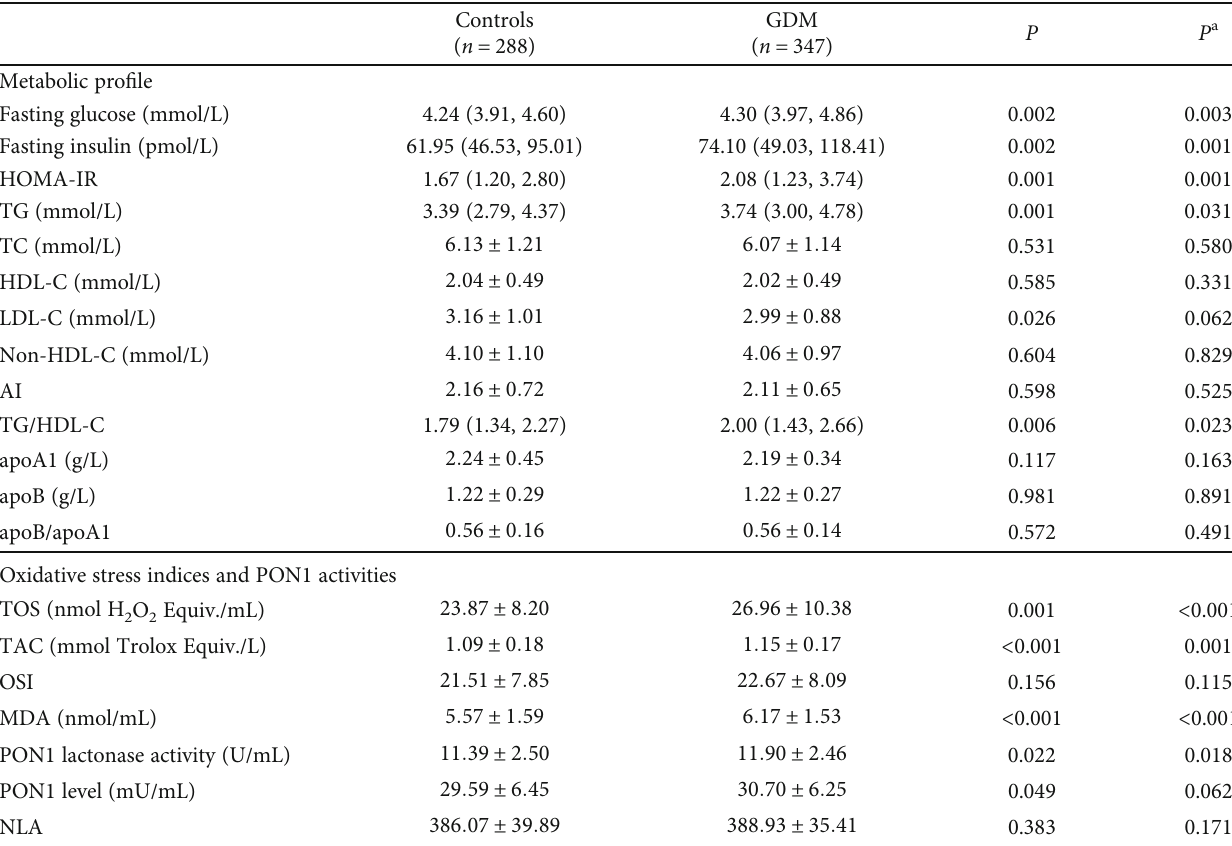
Table 2: Metabolic pro fi le, oxidative stress indices, and PON1 activities of the women with GDM and the women with uncomplicated pregnancies.